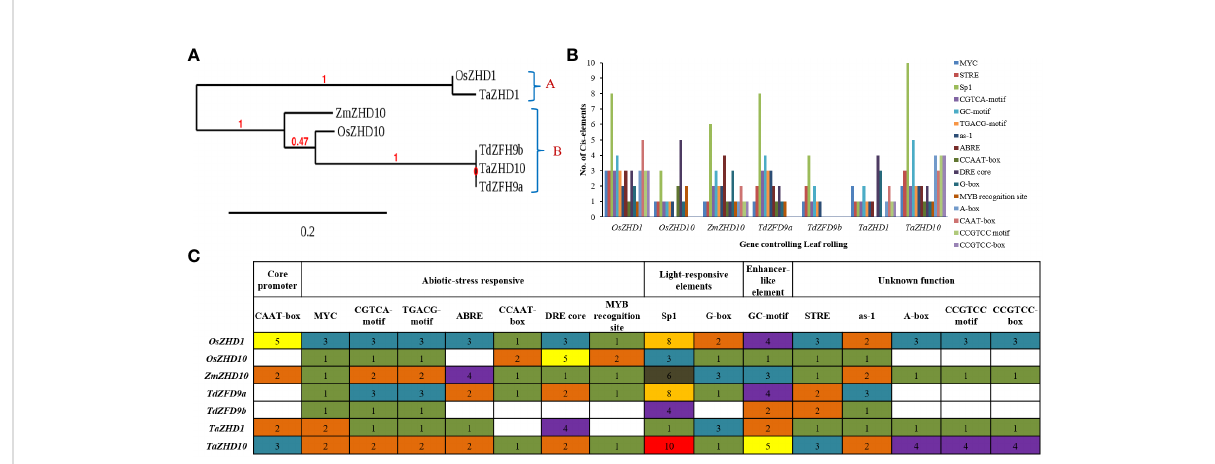
FIGURE 6 Comparative analysis of, (A) phylogenetic tree topology, (B) Cis - acting regulatory elements in promoters, and (C) functional classes of annotated Cis- acting regulatory elements of candidate leaf rolling ZHD genes of wheat and their orthologs ( Cis -acting regulatory elements identi fi ed in genes were represented in the form of